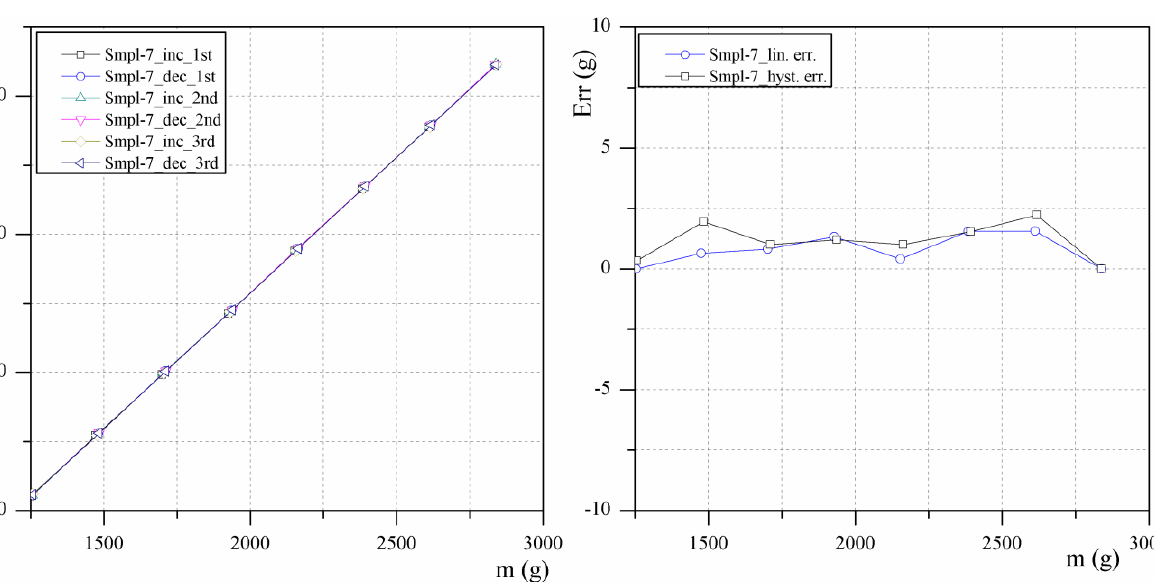
Figure 10. (a) Output voltage versus mechanical load of the sensor––three times repeated measurement and (b) non-linearity error and hysteresis